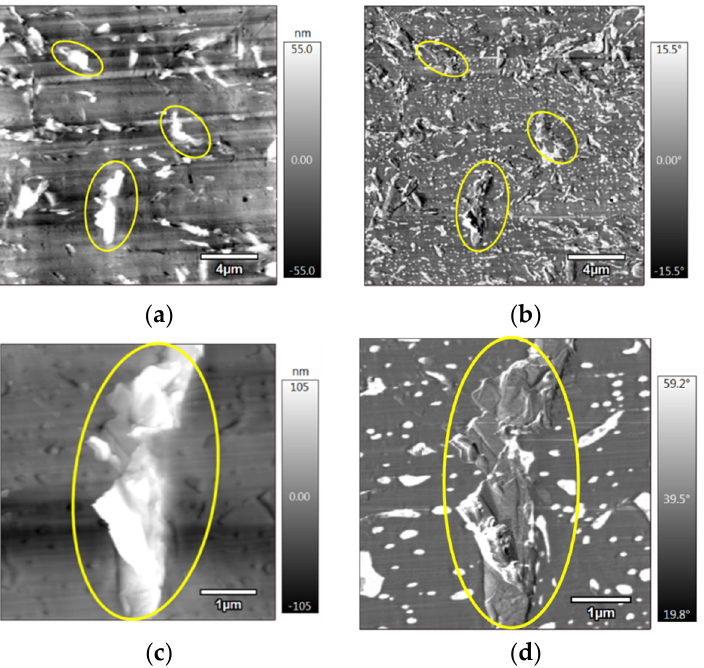
Figure 6. ( a ) AFM topography; ( b ) AFM phase, ( c ) zoomed image of ( a ); ( d ) zoomed image of ( b ), of 3D-printed PLA/PCL/10 wt.% M5 (the yellow circles surround few GNPs.).